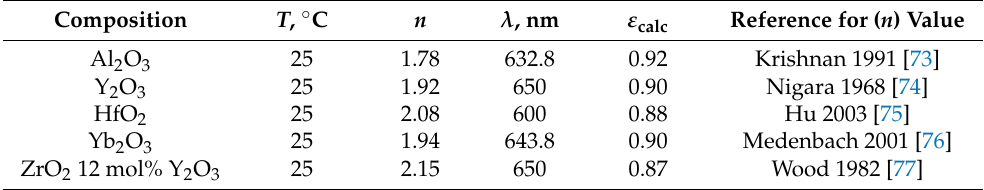
Table 2. Calculated emissivity based on the reported values for the refractive index ( n ).